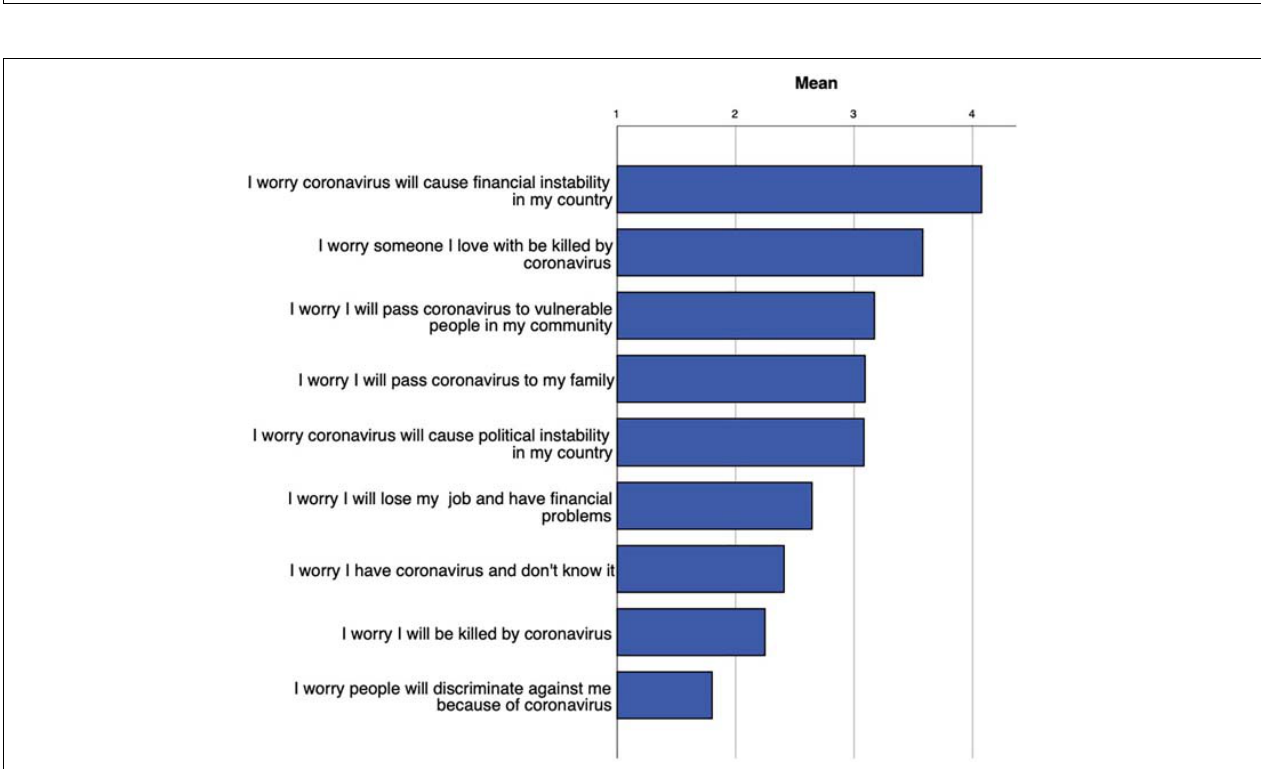
FIGURE 2 | Coronavirus-related worries as reported by participants, ranging from not worried at all (0) to very worried (5).